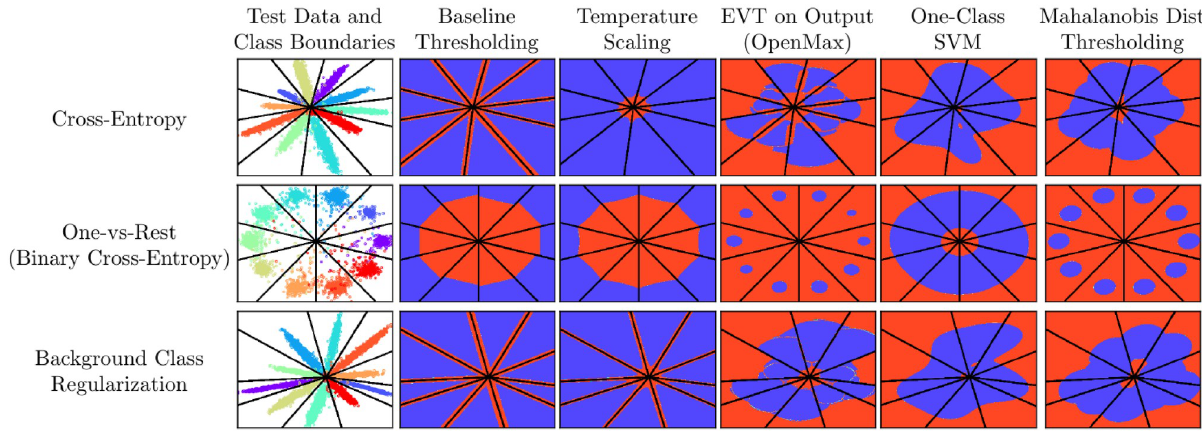
Fig 1. Decision boundaries. 2-D visualization of the decision boundaries created from the different inference methods studied using the LeNet + architecture and MNIST [52] as the training set. Blue is the acceptance region for in-distribution samples calibrated at a 95% True Positive Rate (TPR) for training data. Red is the rejection region (outlier).